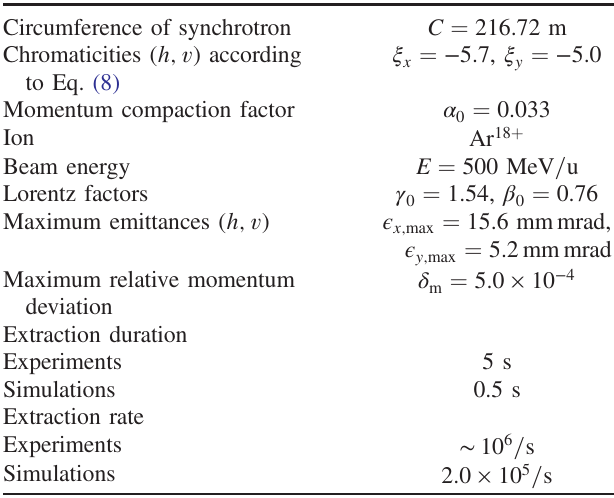
TABLE I. Typical beam and lattice parameters used in experi- ments and